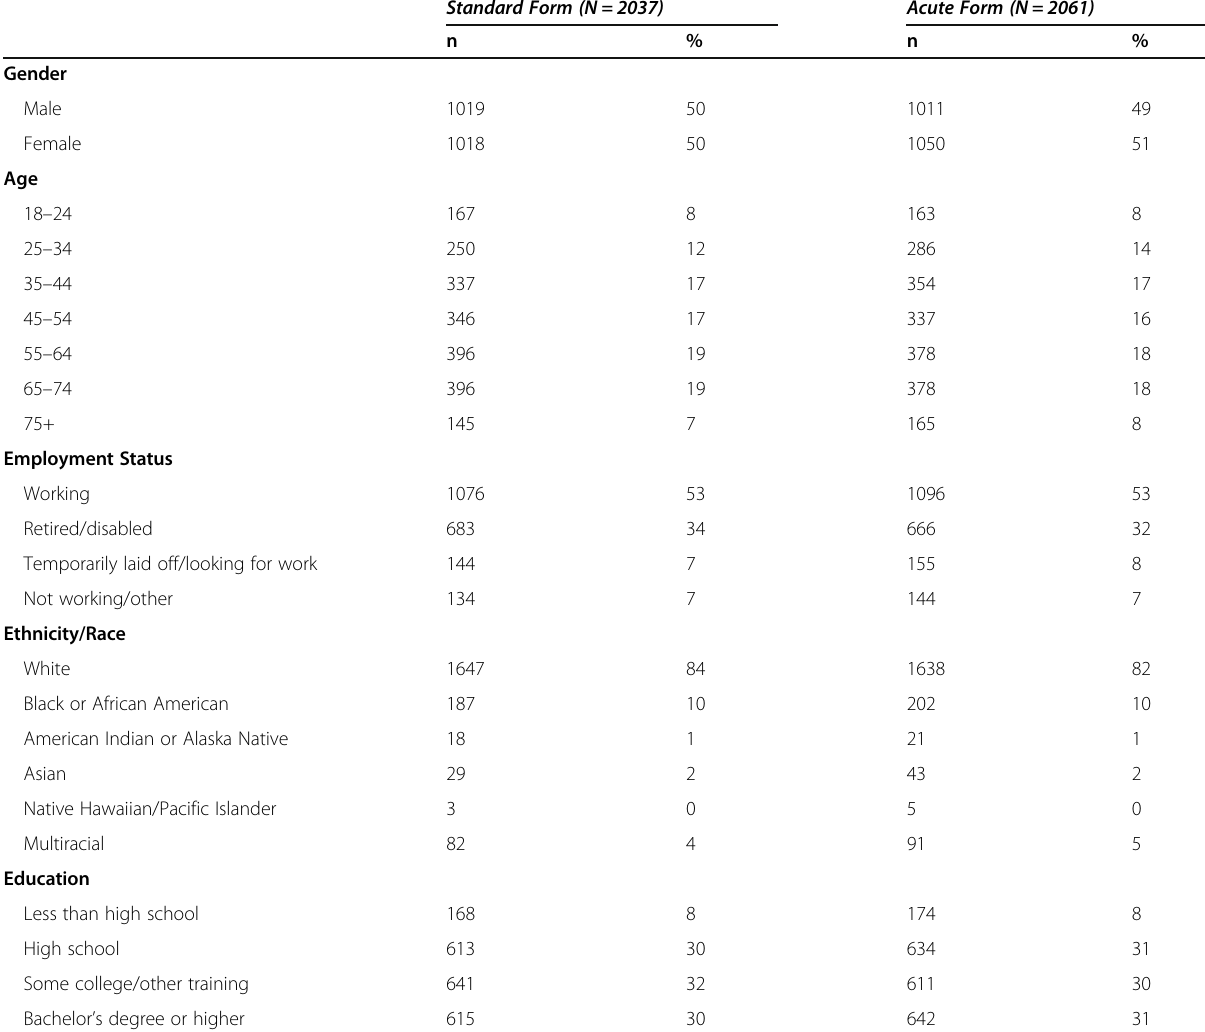
Table 2 Patient characteristics of validation